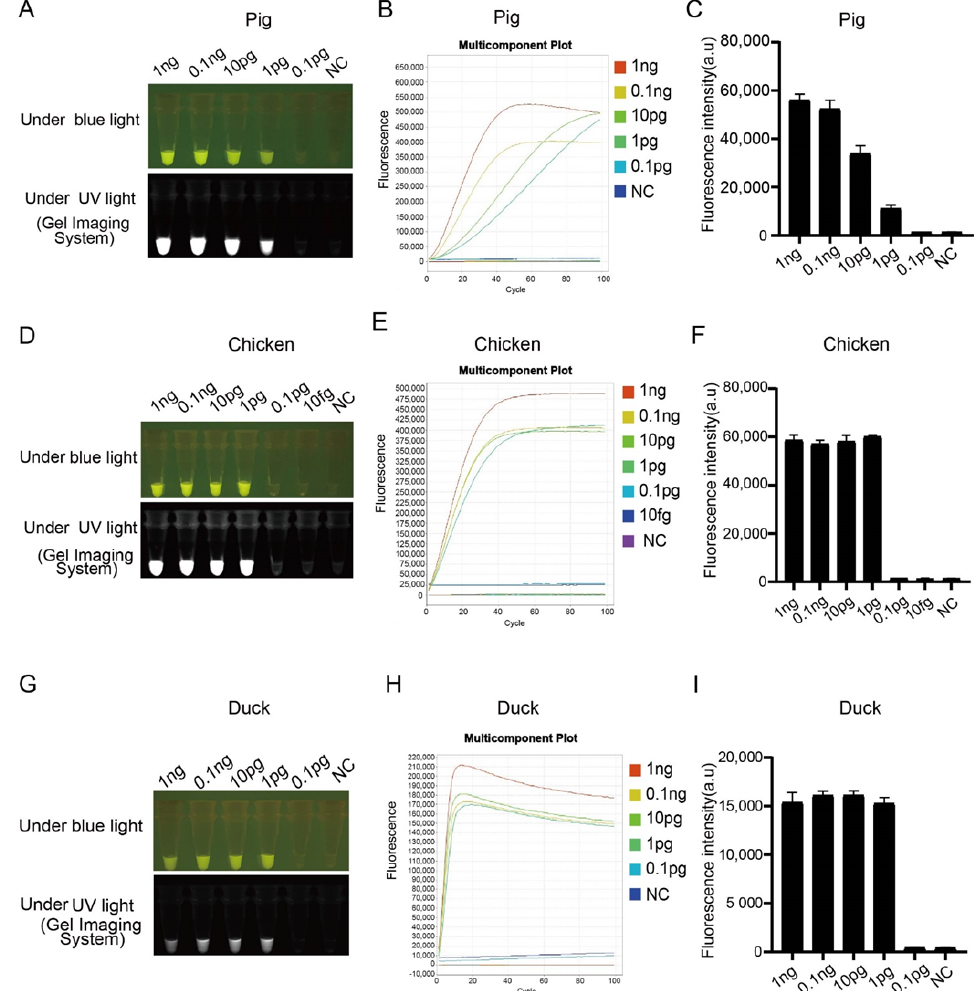
Figure 2. Assessing the sensitivity of LAMP combined with CRISPR/Cas12a technology for pork, chicken and duck meat detection. ( A , D , G ) Sensitivity of LAMP combined with CRISPR/Cas12a tech- nique to visually detect pork, chicken and duck under blue and ultraviolet lights; ( B , E , H ) detection of fluorescence using a real-time PCR machine; ( C , F , I ) the end-point signal intensity measured using a fluorescence microplate reader. Data are represented as means ± SEM; n = 3. NC stands for negative